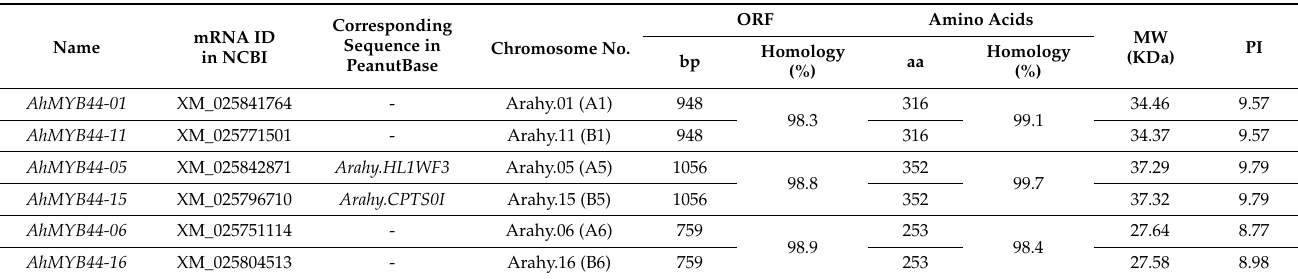
Table 1. General information about AhMYB44s